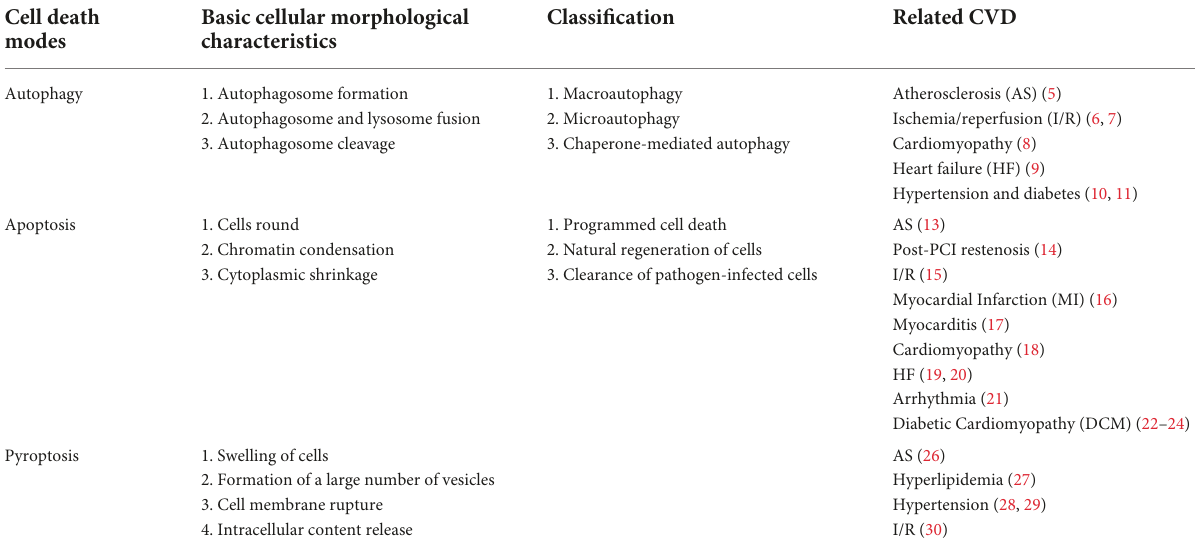
TABLE 1 Cell death pathway and related morphological characteristics and classification and related